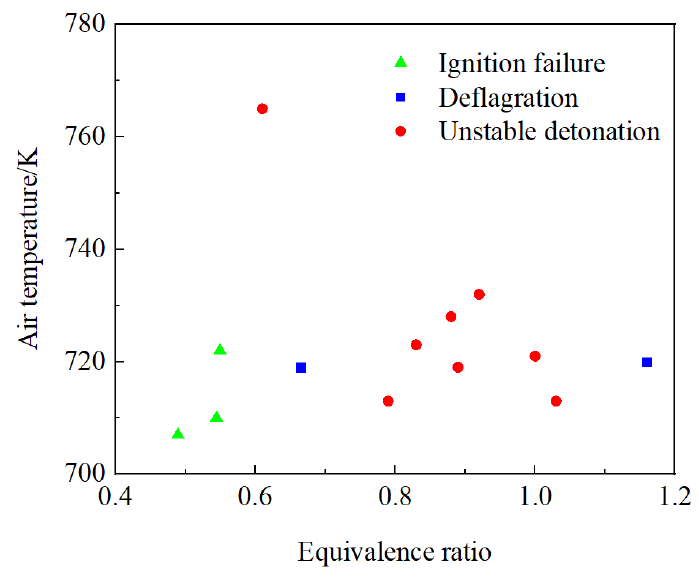
Figure 10. Modes’ distribution of liquid kerosene/hot air rotating detonation.